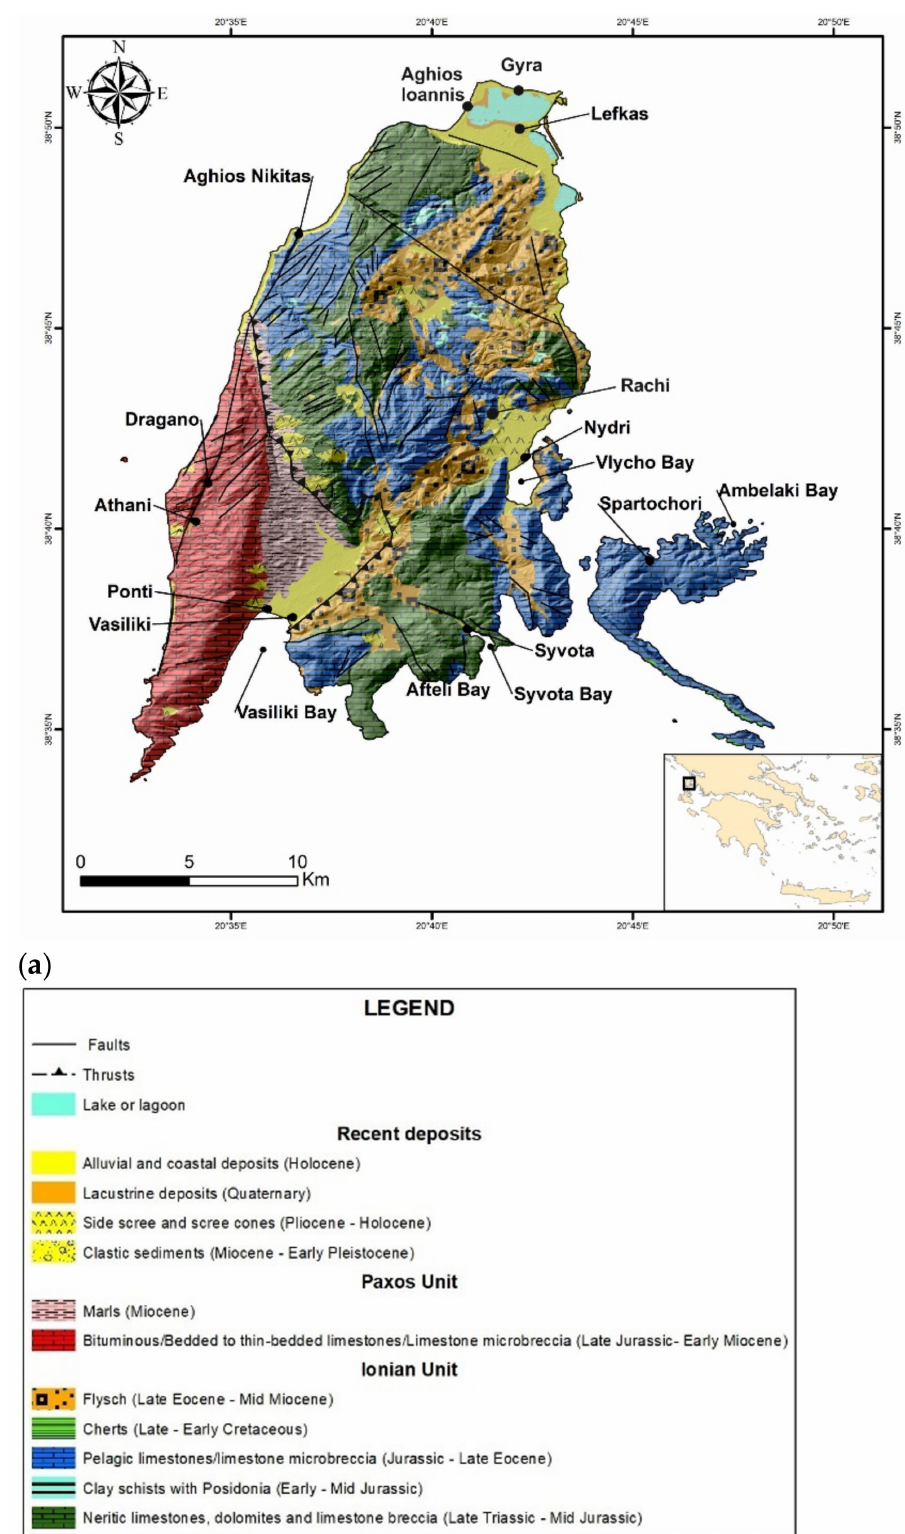
Figure 2. ( a ) Geological map of Lefkas and Meganisi islands, showing the distribution of their geotectonic units and the main faults and thrusts. ( b ) Legend of the geological